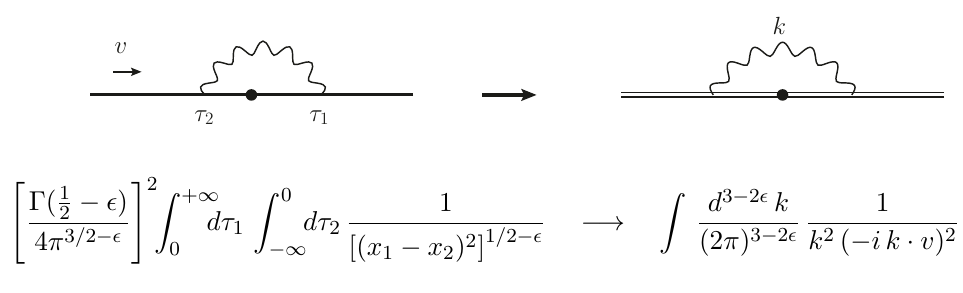
Figure 4 . A cartoon of the WL Fourier transform to a HQET